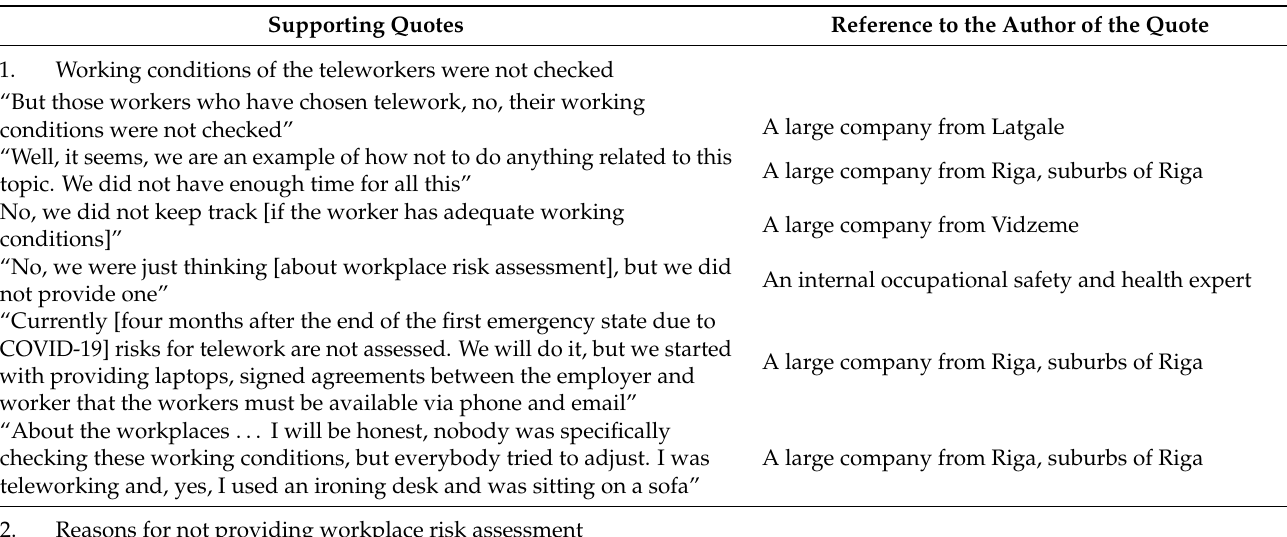
Table A2. The most relevant quotes to support the